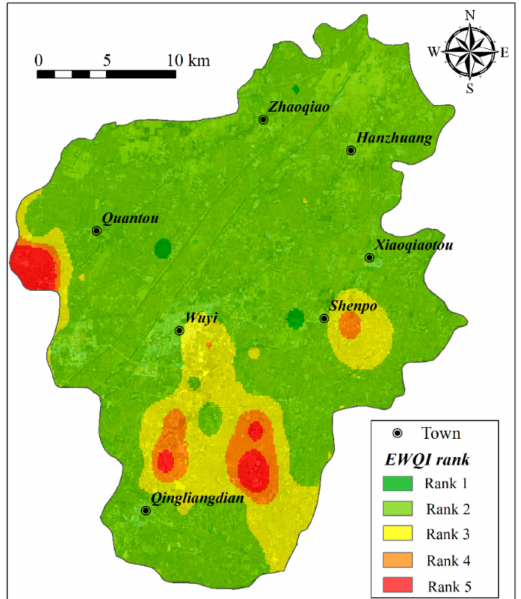
Figure 6. Spatial distribution of the confined groundwater quality rank based on the